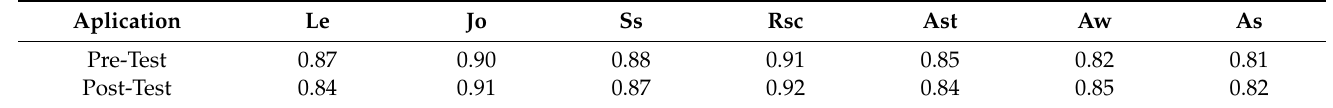
Table 3. Reliability of the BAS-2